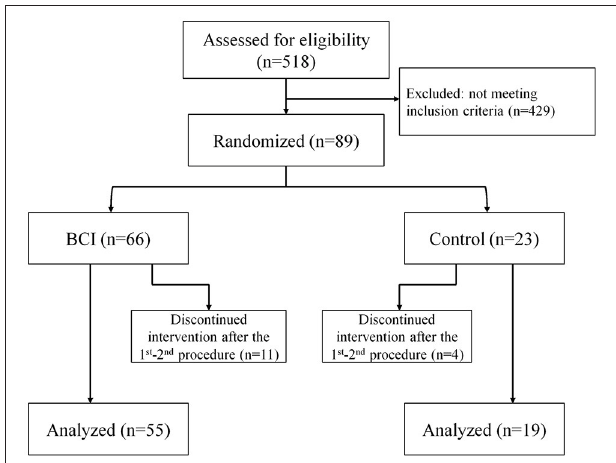
FIGURE 1 | The subject flow diagram from recruitment through analysis (Consolidated Standards of Reporting Trials flow diagram).